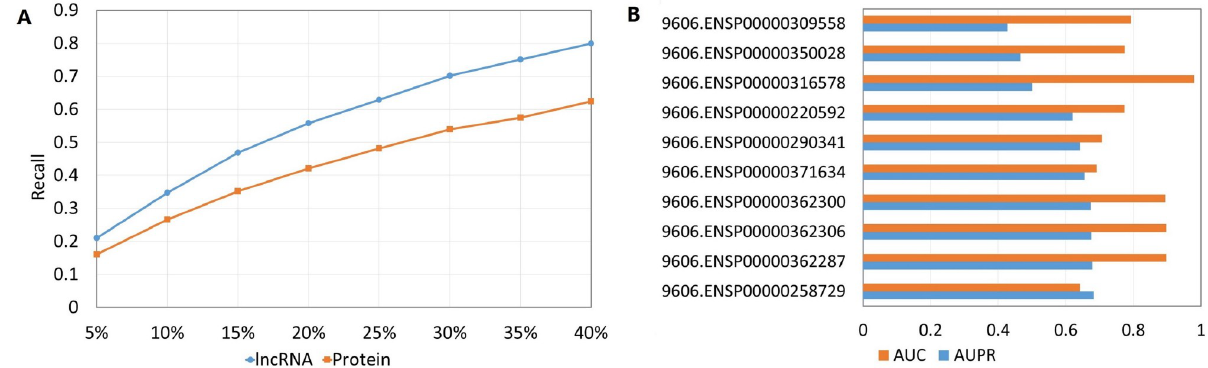
resource allocation algorithm. KATZLGO constructed a heterogeneous network based on lncRNA-lncRNA similarity, lncRNA-protein interactions and protein-protein similarity, and then adopted KATZ measure to calculate distances between lncRNAs and proteins in the net- work. LPI-ETSLP calculated lncRNA-lncRNA similarity and protein-protein similarity based on pairwise sequence Smith-Waterman scores, and then built semi-supervised link prediction classifier based on these similarities. LPNLP calculated three lncRNA-lncRNA similarities and two protein-protein similarities by using linear neighborhood similarity measure, and imple- mented label propagation to develop the integrated models. First, we respectively build different prediction models based on the benchmark dataset. The benchmark methods were designed to predict unobserved interaction between know lncRNAs and know proteins. Therefore, we implement these methods and mainly evaluate their performances in predicting unobserved interactions under CV . As shown in Table 2, lp the AUPR values of RWR, LPBNI, KATZLGO, LPI-ETSLP, LPLNP and SFPEL-LPI are 0.236,